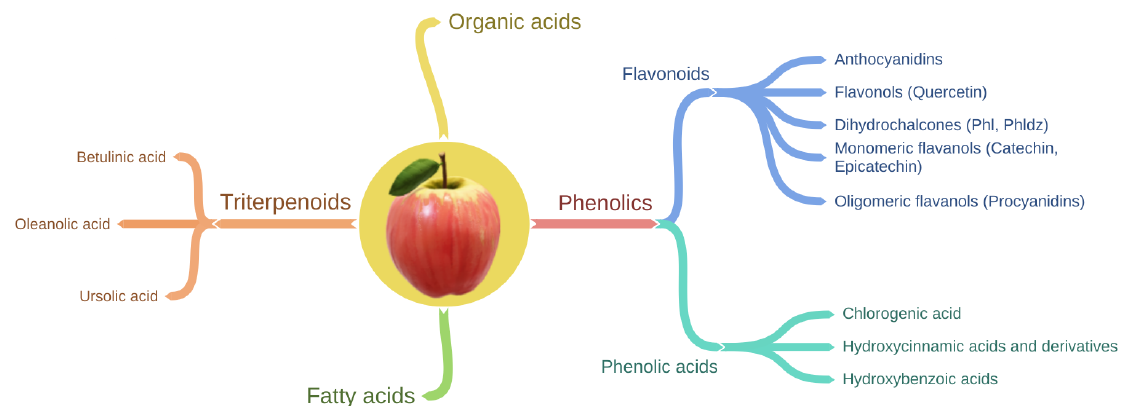
Figure 1. Schematic showing the classification of phytochemicals present in apple.